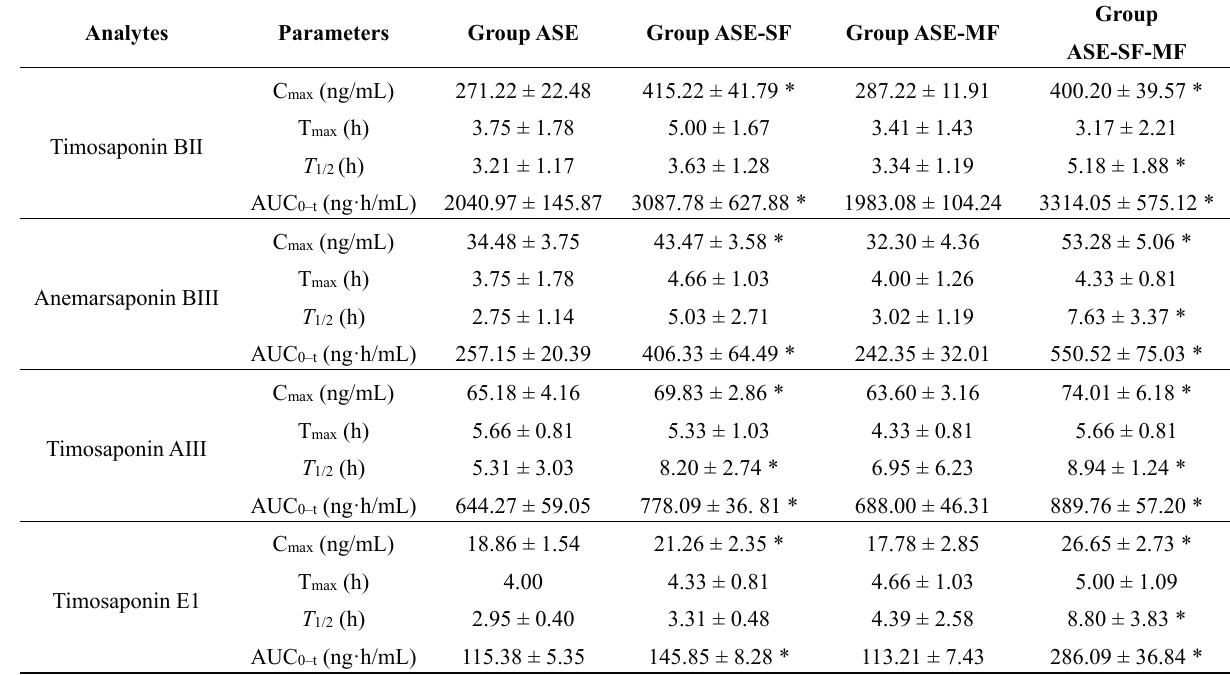
Table 5. Pharmacokinetics parameters of four steroidal saponins after an oral administration ( n = 6). Analytes Parameters Group ASE Group ASE-SF Group ASE-MF